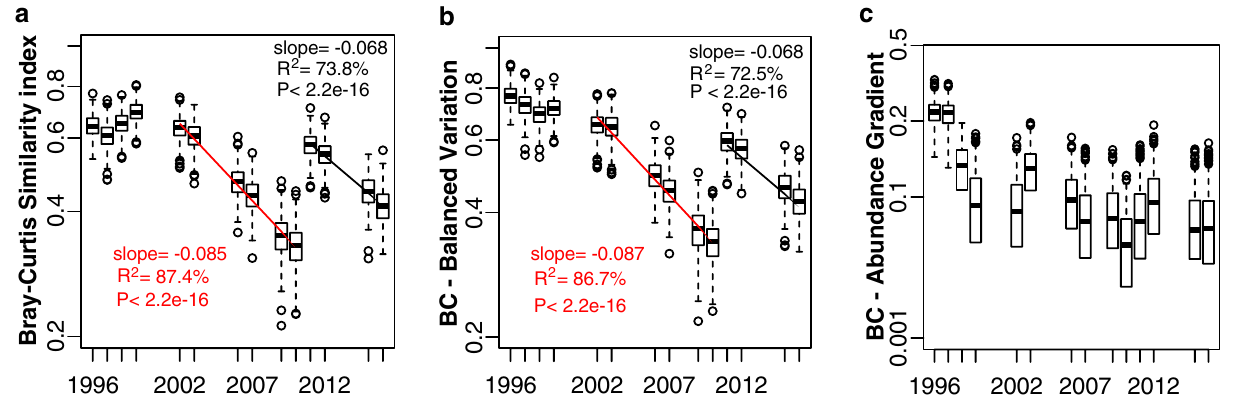
Figure 4. Similarity between pneumococcal communities following introduction of PCVs. ( a ) Bray–Curtis similarity index over time; ( b ) proportion of the Bray–Curtis similarity index explained by serotype replacement (balanced variation in abundance); ( c ) proportion of the Bray–Curtis similarity explained by serotype expassion/reduction (gradient component). For the period 2002–2010, when PCV7 was used, the similarity of each year was compared with the pneumococcal serotype community of 2001; for the period 2011–2016, when PCV13 was used, the similarity of each year was compared with the pneumococcal serotype community in 2010. Boxplots represent the summary of 1000 similarity estimates based on bootstrap re-sampling. In ( a ) and ( b ), for each period an exponential decay model was fitted to the data: the red solid line corresponds to the PCV7 period, the black solid line corresponds to the PCV13 period. The slope, the significance of the model, and the variance ( R 2 ) explained by each model, are indicated.